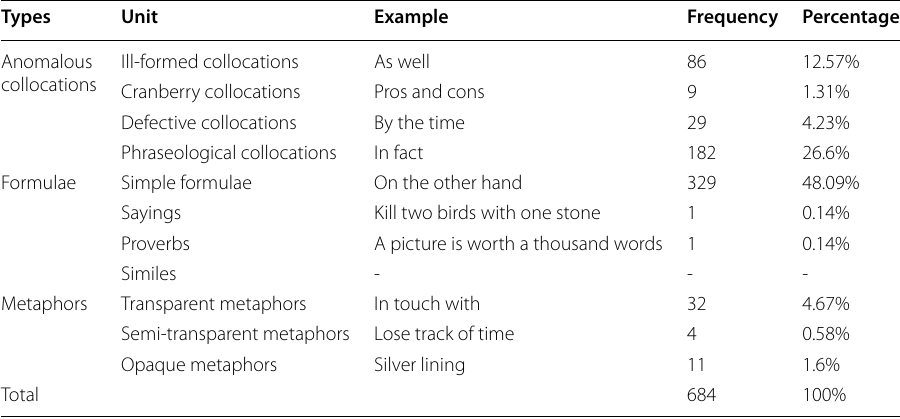
Table 5 Phraseological units used in IELTS task 2 based on Moon’s (1998) typology Types